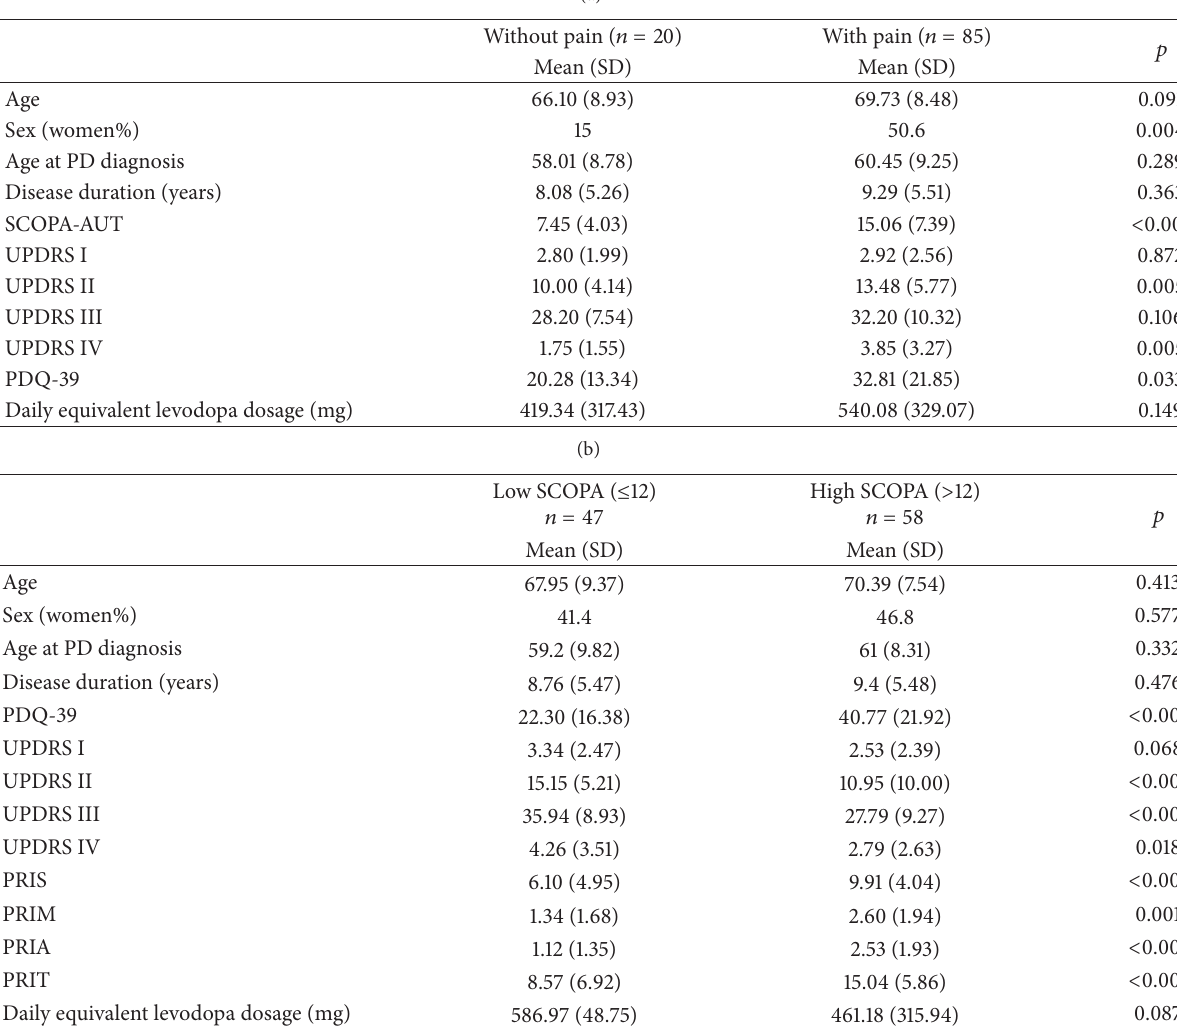
Table 2: (a) Bivariant analysis by pain (without/with) 𝑛 = 105 . (b) Bivariant analysis by dysautonomic symptoms, 𝑛 = 105 .